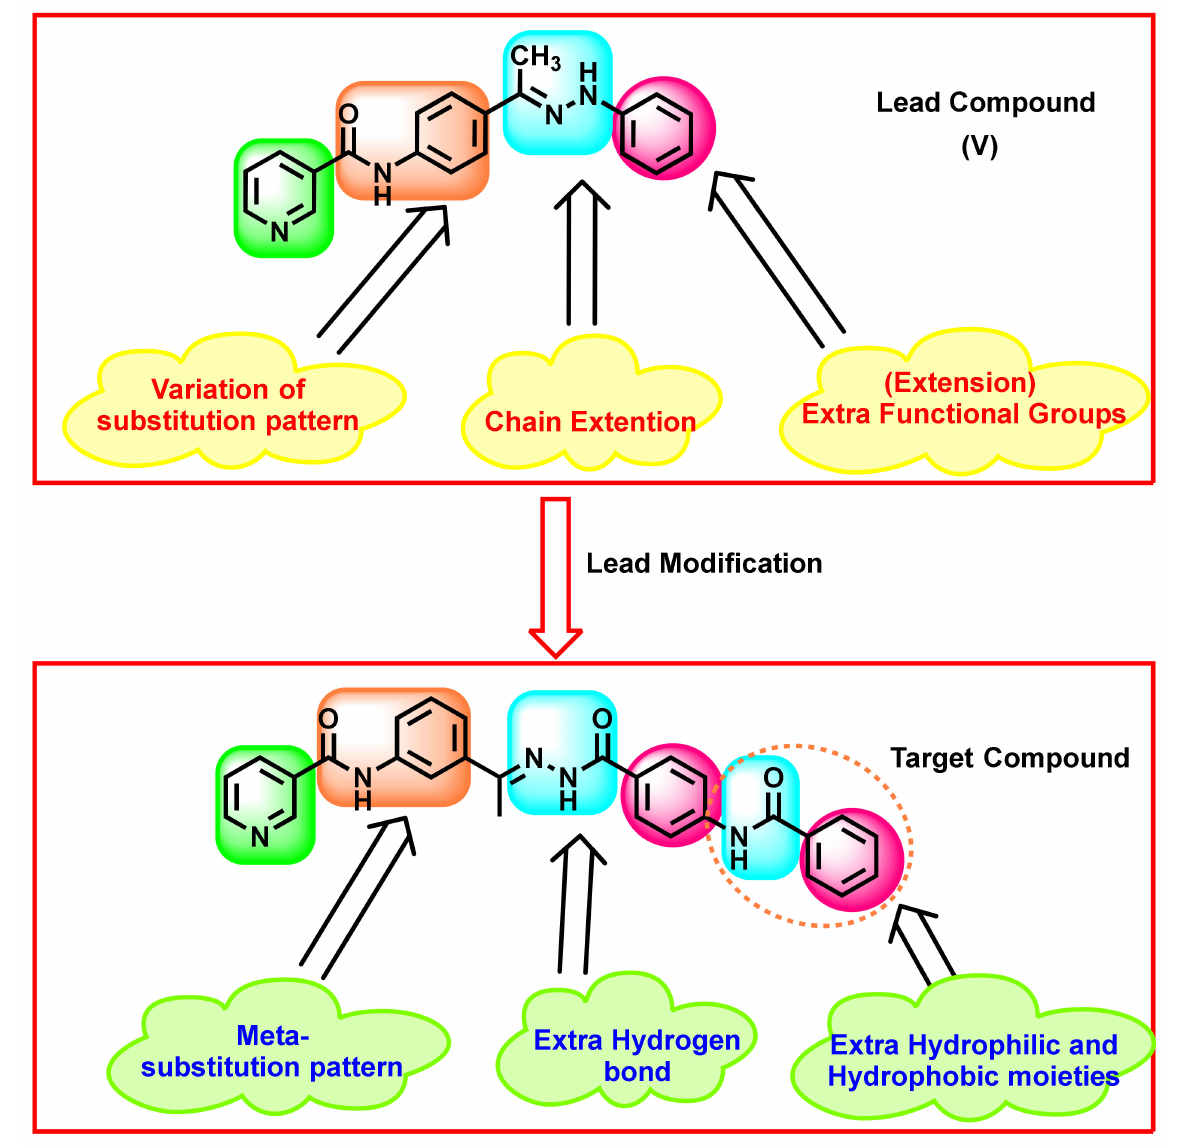
Figure 2. The design rationale of the targeted